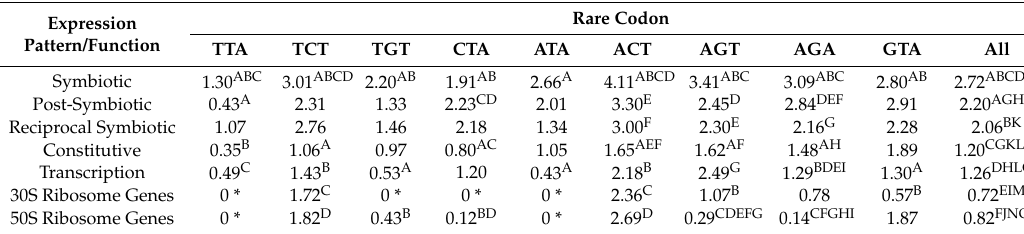
Table 5. The frequency of rare codons in each expression pattern and in the transcription and translation functions. Values are frequency per 1000 codons. The lettered superscripts indicate a statistical difference ( p < 0.5) between similar indicated values. The asterisks (*) indicate that the value of 0 is statistically different from each of the other